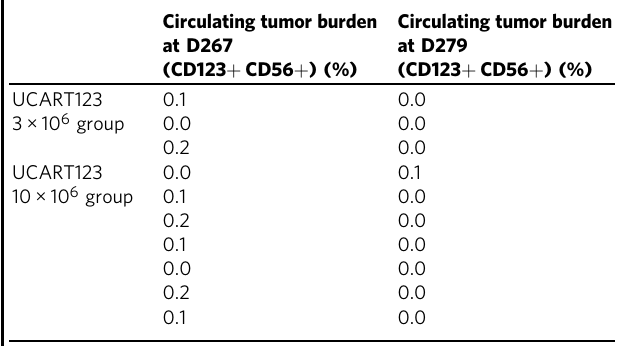
Table 2 Circulating tumor (BPDCN) burden in mice after treatment with